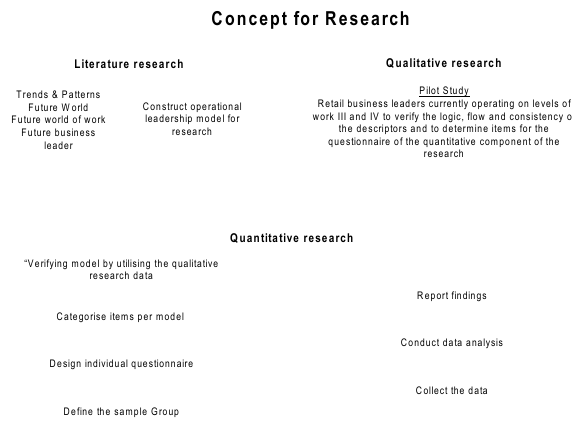
Figure 1: Conceptual approach for research